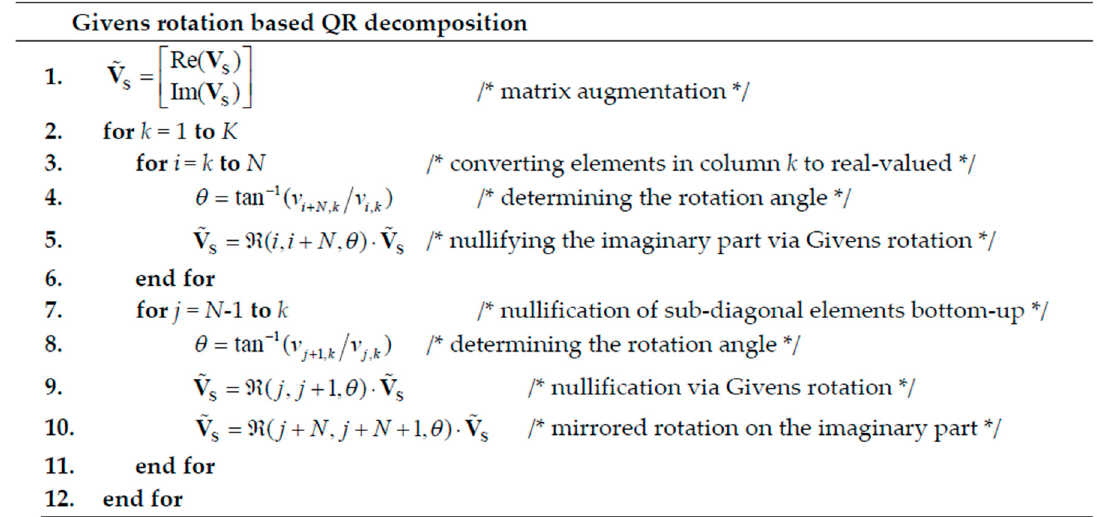
Figure 4. Pseudo code of Givens rotation based QR decomposition.